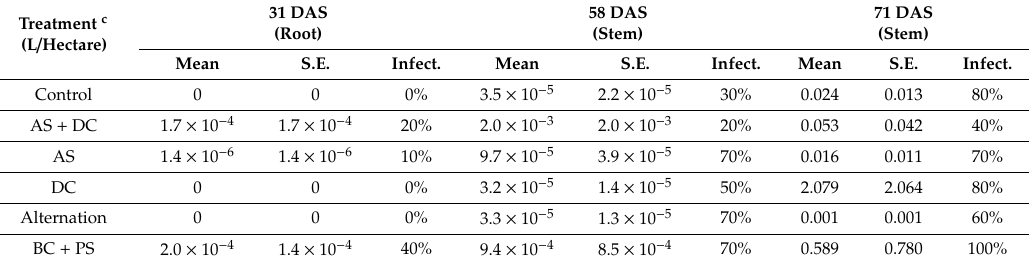
Table 8. qPCR diagnosis in the field (Amir, summer 2018) a . Treatment c (L /